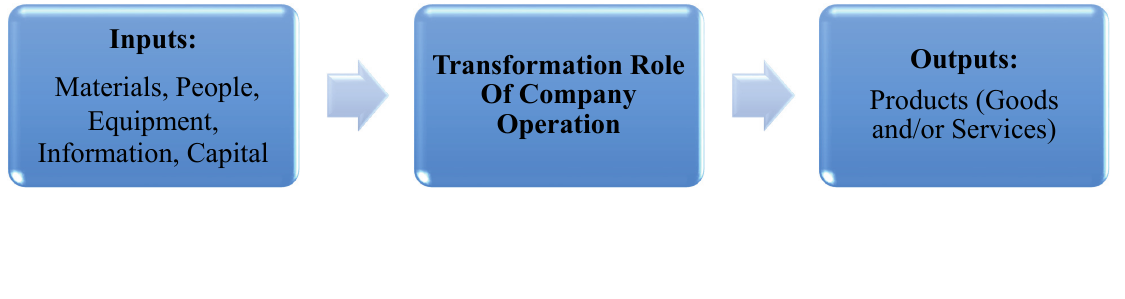
Fig. 2. The transformation role of company